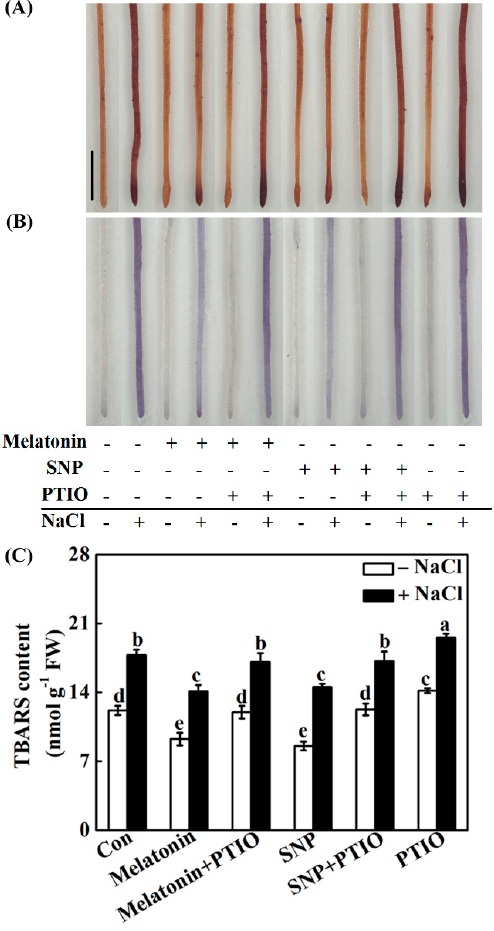
Figure 6. Redox balance was reestablished by melatonin via NO. Three-day-old rapeseed seedlings were pretreated with 1 µ M melatonin, 10 µ M SNP, 200 µ M PTIO, alone or their combinations for 12 h, and then transferred to 200 mM NaCl for another 2 days. Afterwards, seedling roots were stained with DAB ( A ) and NBT ( B ) to detect H 2 O 2 and O 2 − . Scale bar = 1 cm. TBARS content ( C ) were also determined. The sample without chemicals was the control (Con). Values are means ± SE of three independent experiments with at least three replicates for each. Bars with different letters are significant different at p < 0.05 according to Duncan’s multiple range